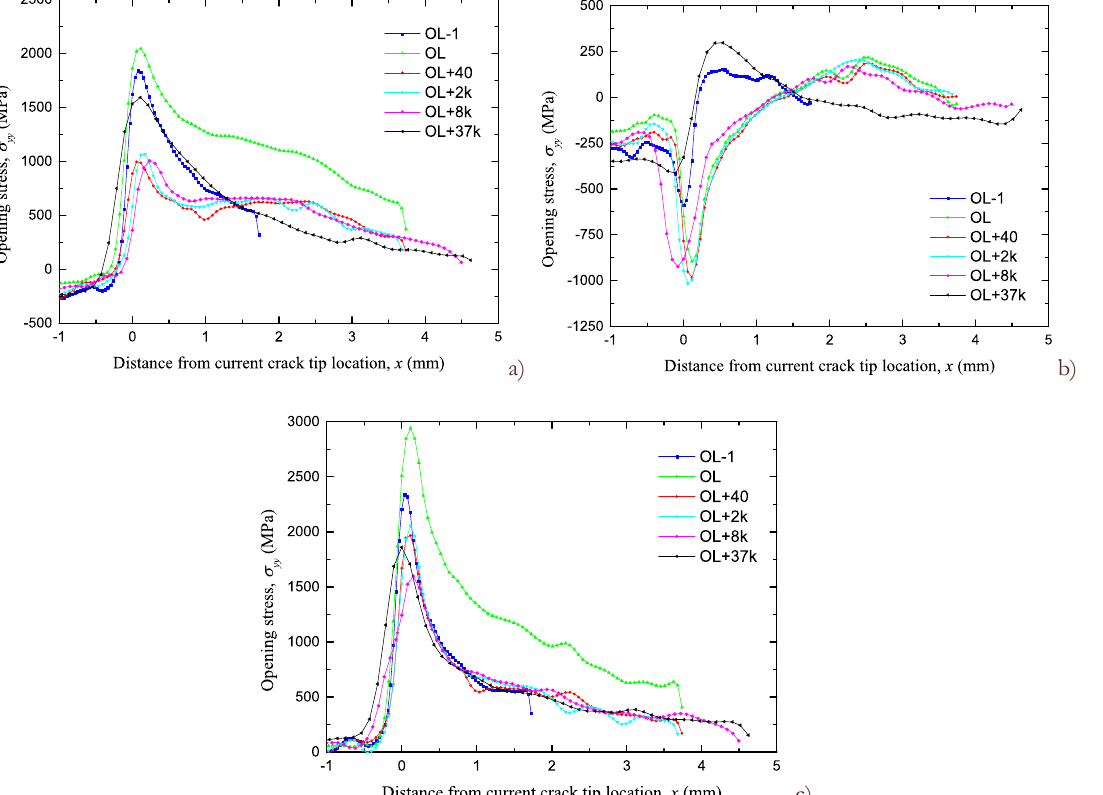
Figure 5: XRD line profiles along y=0 showing the crack loading stress  yy (MPa) a) at maximum load b) at minimum load and c) the difference between the stresses at maximum and minimum load at each stage in the fatigue crack growth